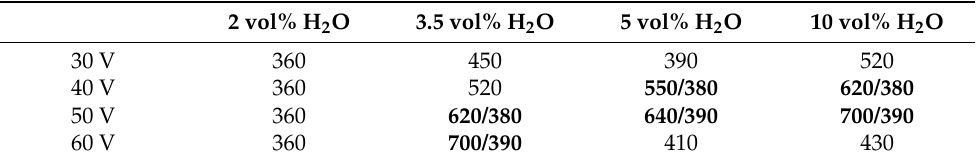
Table 1. Wavelength values [nm] for the maximum reflectance obtained for samples generated in all tested electrolyte